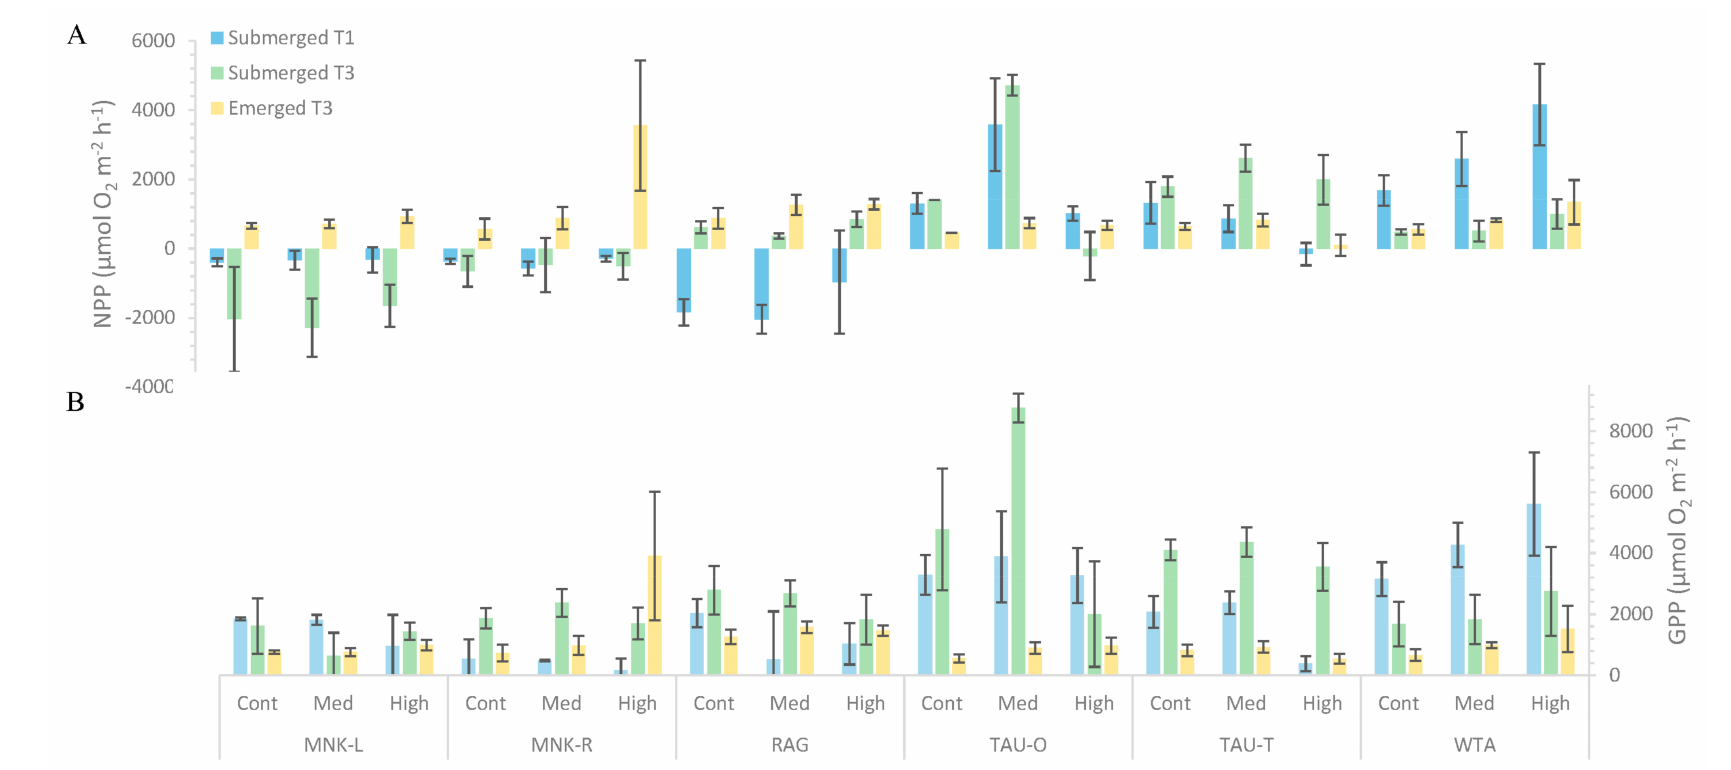
Figure A1. Primary production measures ( A ) NPP and ( B ) GPP as a function of site, nutrient enrichment treatment, tidal state and